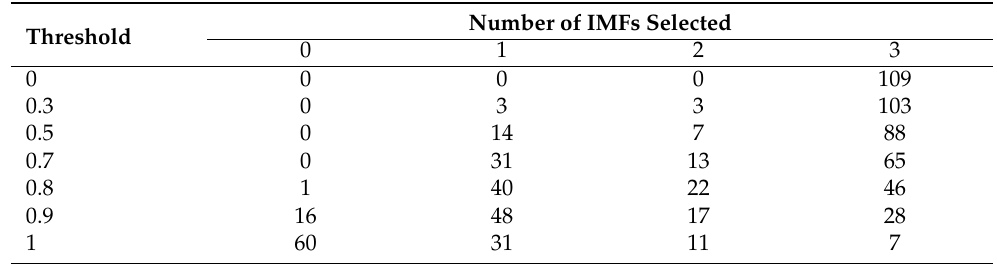
Figure 8. Mean rank of CEEMD-MultiRocket using different threshold. Table 5. Number of datasets of selecting different number of IMFs using different thresholds on 109 datasets from the UCR time series